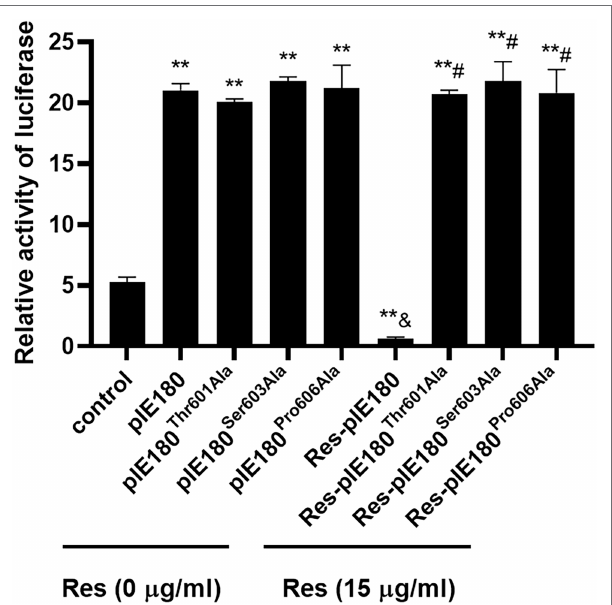
FIGURE 7 | The effects of Res on IE180 activation were detected using the dual-luciferase assay. The 293 T cells were co-transfected with the effector plasmid pcDNA3.1(+)/pIE180//pIE180 Thr601Ala /pIE180 Ser603Ala /pIE180 Pro606Ala , the reporter plasmid pGL3-TK, the internal control plasmid pRL-TK, respectively. After incubation for 24 h, the Res (15 μ g/ml) was added to the plate to treat for 48 h, and relative luciferase activity was measured. ** p < 0.01 represents a significant difference compared to the control group; # p < 0.01 represents a significant difference compared to the Res-pIE180 group; and & p < 0.01 represents a significant difference compared to the pIE180 group ( n = 3, in each